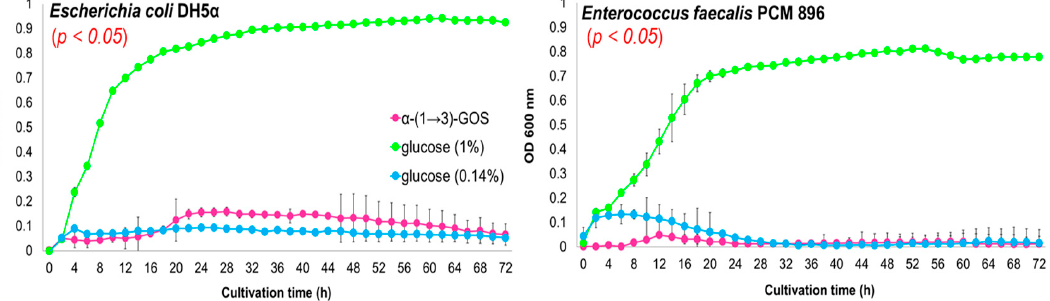
Figure 3. Growth curves of Escherichia coli DH5 α and Enterococcus faecalis PCM 896 in basal medium supplemented with α -(1 → 3)-GOS and glucose. The number of bacteria is reported as a change in optical density. The results are given as means ± SD of triplicate samples.